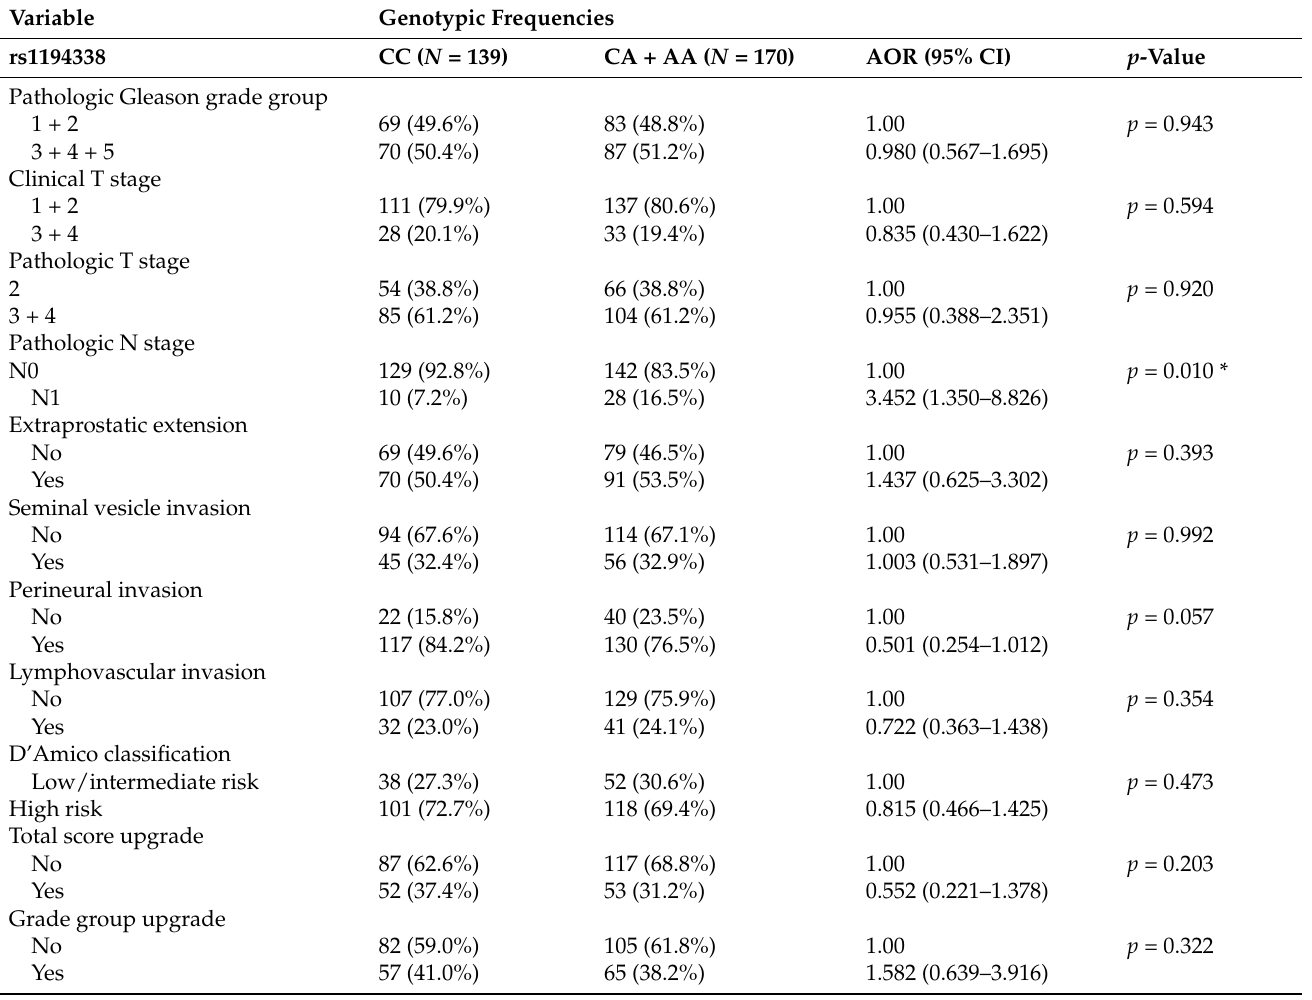
Table 5. Odds ratio (OR) and 95% confidence interval (CI) of clinical status and MALAT1 rs1194338 genotypic frequencies in 309 patients with prostate cancer with a PSA concentration >10